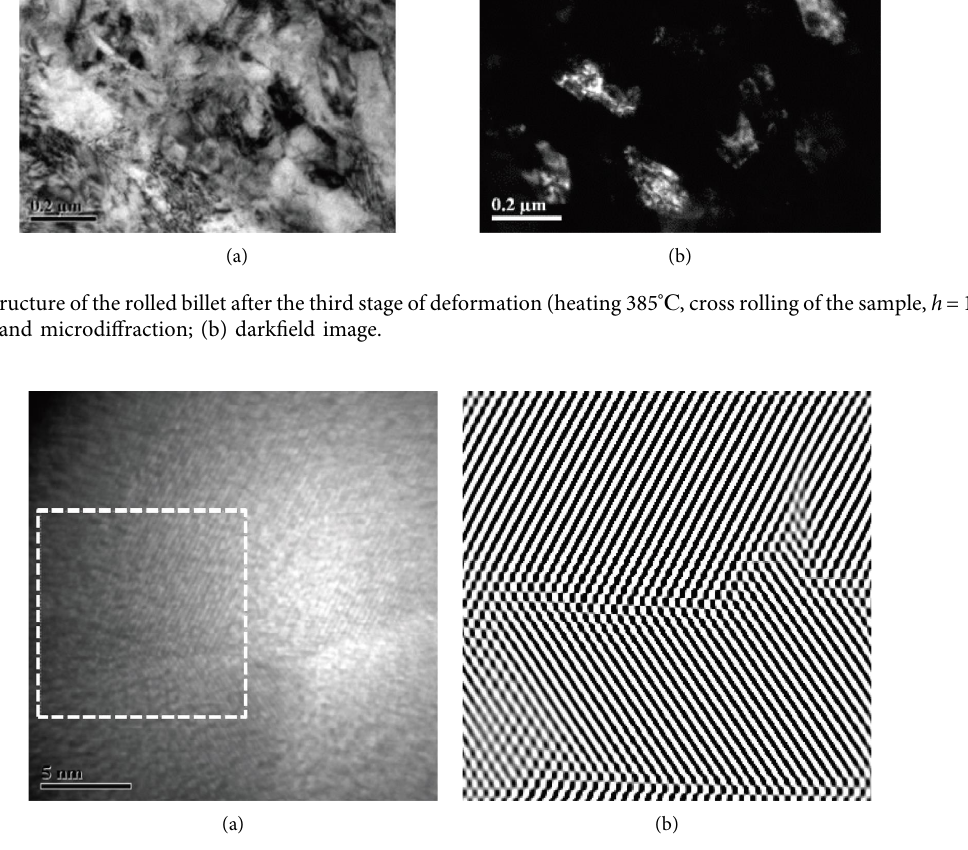
Figure 14: Microstructure in the area of crystallite boundaries in the sample after the TE and the second stage of rolling ( h � 2.5mm, heating 350 ° C): (a) crystallite boundary fragment in the sample; (b) FFT processing of the selected area.